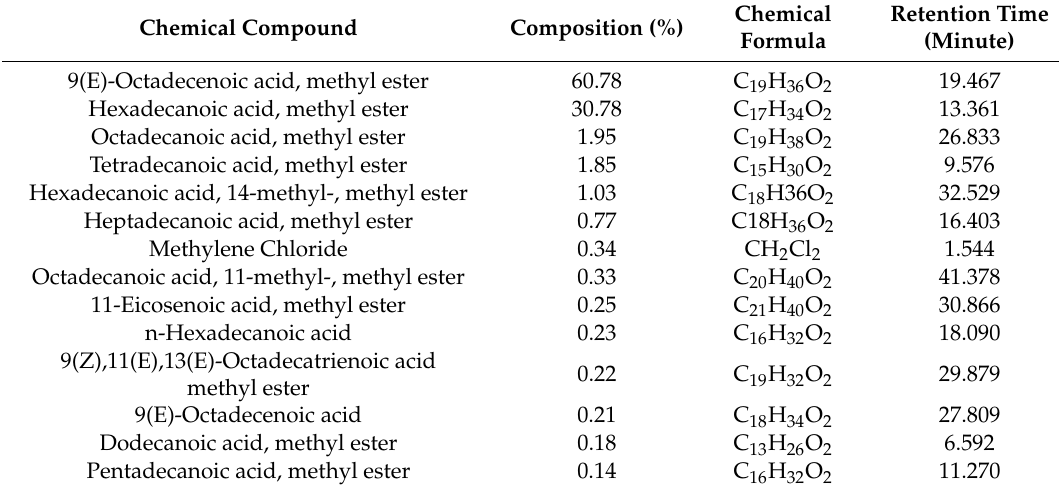
Table 1. Fatty acid methyl ester (FAME) composition by GC-MS from esterified palm oil mill effluent (POME) samples.